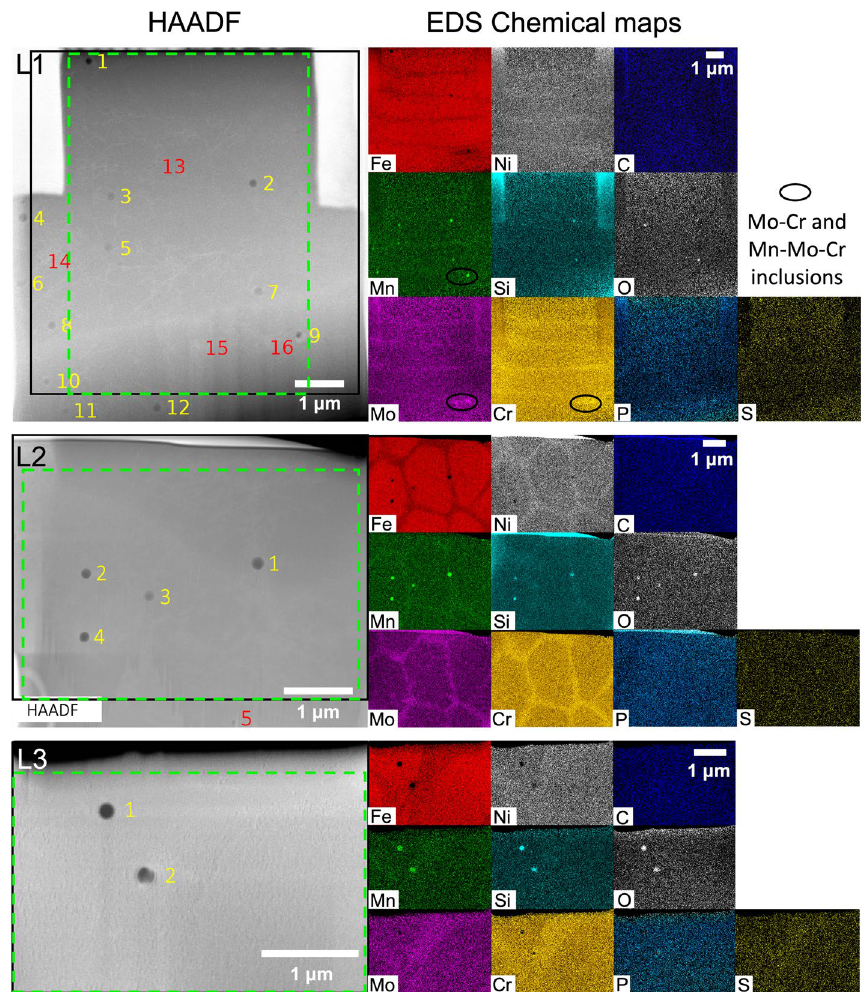
Figure 2. STEM HAADF images and EDS chemical maps of L1, L2 and L3 extracted from the 3-layer wall of Fig. 1. EDS maps have been generated from within the black outlined region in each HAADF image. The dotted green lines in each HAADF image represents the zone where the lamella composition has been computed and presented in Table S1 (Supplementary Data). Precipitates that are easily visible in the HAADF images are numbered in yellow font. Precipitates that have been detected after high resolution imaging are numbered in red font. Scale for EDS maps of each lamella are shown in their C map. HAADF images and EDS maps have been acquired using the TIA v4.2 (FEI https:// www. fei. com) and the Esprit v1.9 (Brucker https:// www. bruker. com) software, respectively. Fiji v2.1.0/1.53c (https:// fiji. sc/) and Microsoft Powerpoint have been used to prepare this